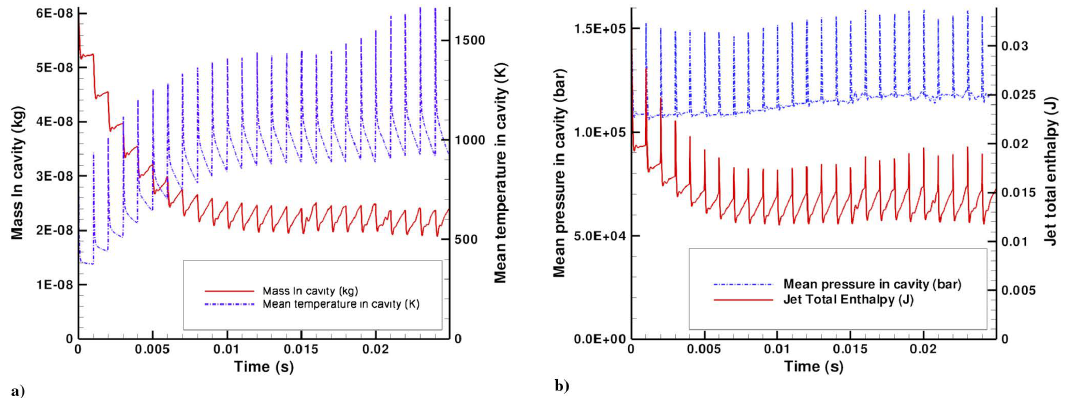
Figure 9. Temporal evolution of: ( a ) mass and mean temperature versus time; ( b ) mean pressure and total jet enthalpy versus time [16].